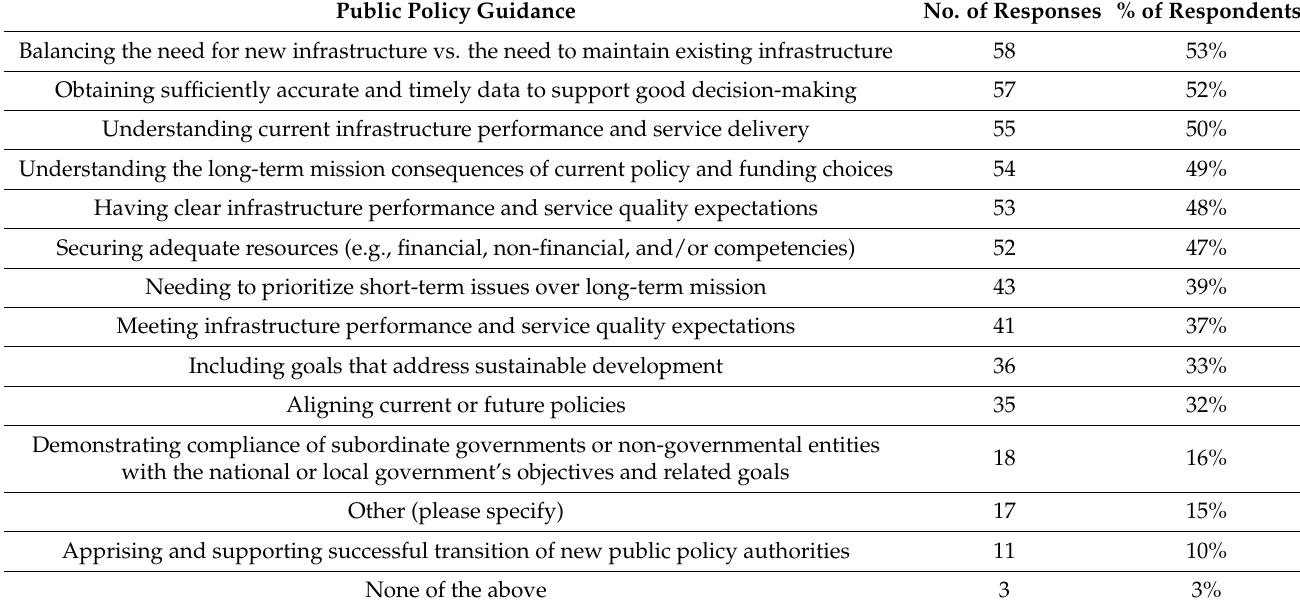
Table 5. Areas government would benefit from additional public policy guidance or assistance related to asset